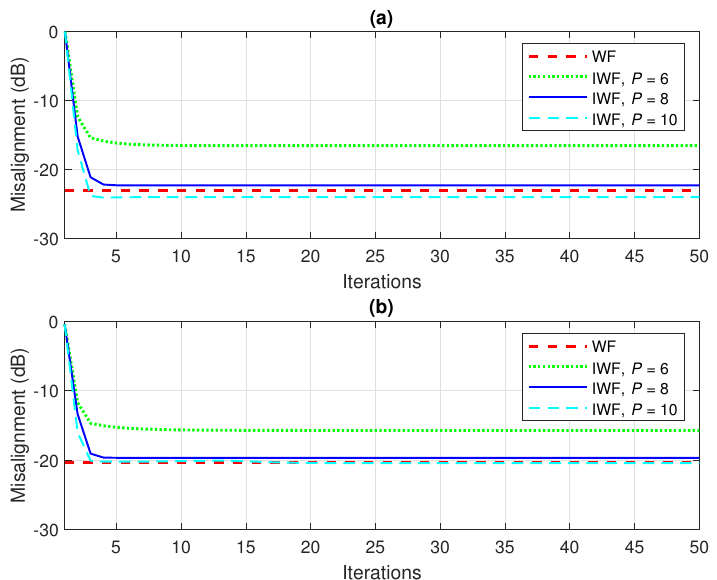
Figure 4. Performance of the conventional Wiener filter (WF) and the iterative Wiener filter (IWF) for the identification of ( a ) the acoustic echo path from Figure 1c and ( b ) the acoustic echo path from Figure 1d. The input signal is an AR(1) process, N = 5000 (available data samples), and SNR = 20